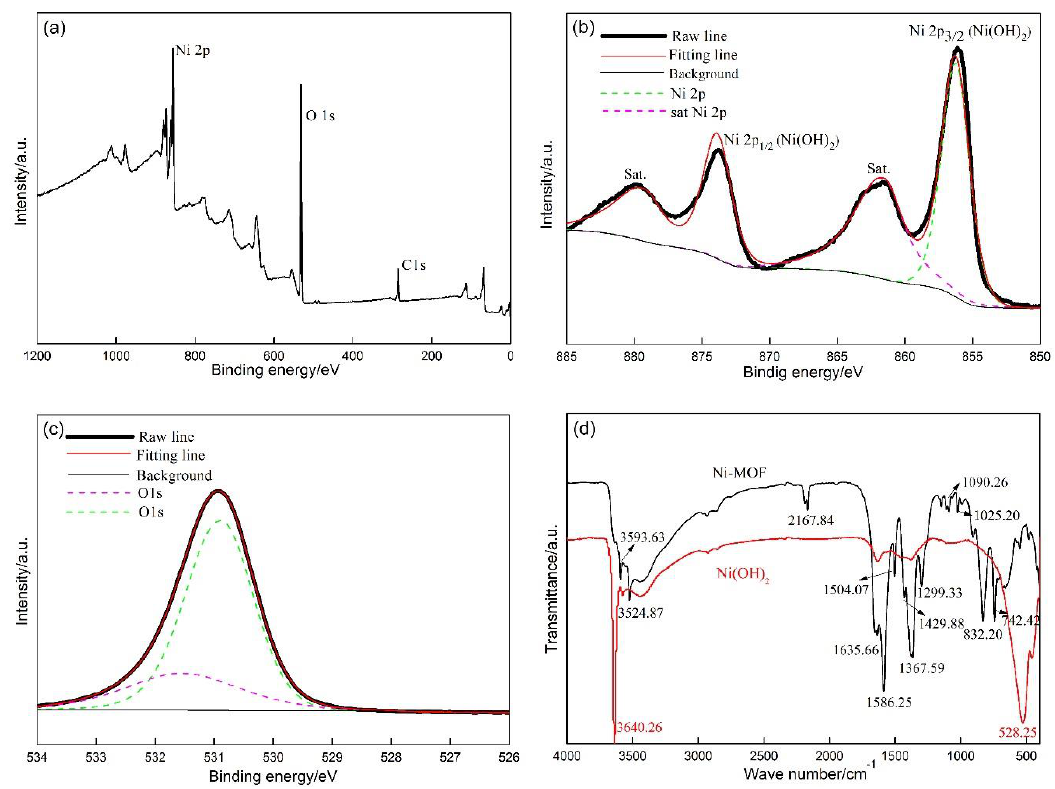
Figure 2. ( a ) Survey XPS spectrum, high resolution spectra of Ni 2p ( b ), O 1s ( c ) of the Ni(OH) 2 , ( d ) FTIR spectra of Ni-MOF and Ni(OH) 2 . ( d ) FTIR spectra of Ni-MOF and Ni(OH) 2